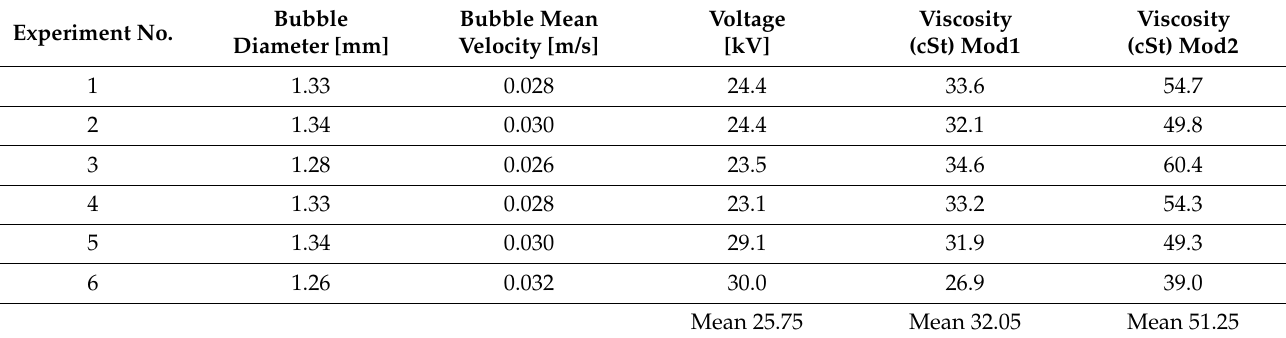
Figure 23. Improvement in the definition of the bubble using the ImageJ program for measuring the diameter.